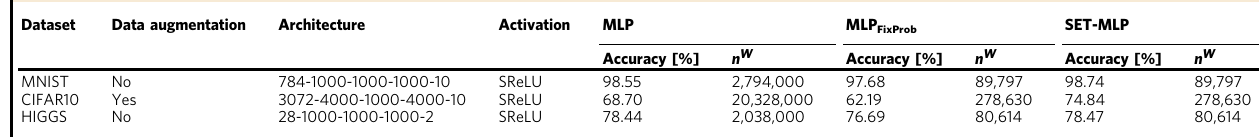
Table 3 Summarization of the experiments with MLP variants